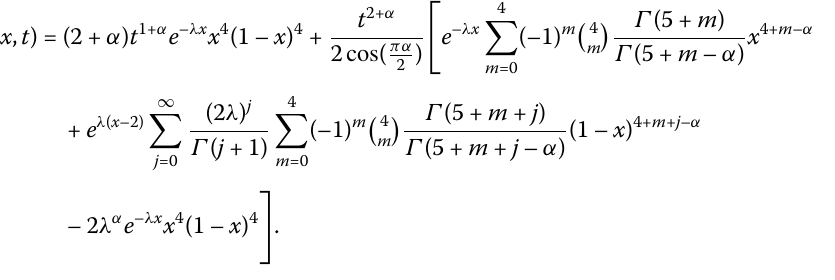
where 1 < α < 2, the linear source term g ( x , t )